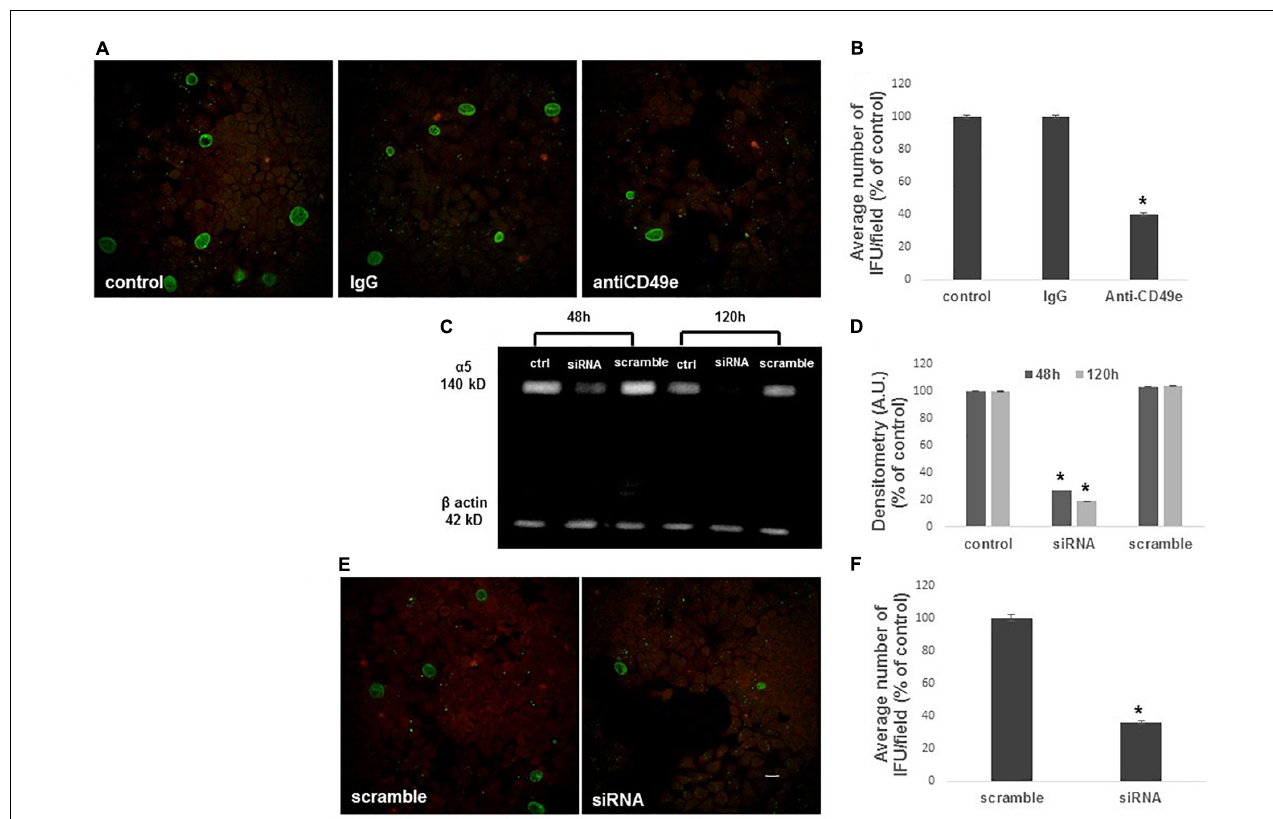
FIGURE 4 | Inhibition of C. trachomatis infection by α 5 integrin subunit blocking or ITGA5 gene silencing. HeLa cells were treated or not with an anti-CD49e antibody or control IgG for 1 h, then infected with CT EBs for 48 h. (A,B) Specimens were stained for chlamydial membrane lipopolysaccharide antigen. Representative micrographs are shown. C. trachomatis infectivity was evaluated as number of IFUs/microscopic field. Results were expressed in percentage compared with control, taken as 100%. Bars represent median values, error bars represent median absolute deviations. Statistical significance was calculated vs. control. ∗ P ≤ 0.01. (C,D) Western blotting of α 5 integrin subunit expression in control, ITGA 5 siRNA and scramble Hela cells, evaluated at 48 and 120 h post-siRNA. Quantification of α 5 integrin subunit was normalized on β -actin. Bars represent mean values based on three independent experiments, error bars represent standard deviations. (E,F) HeLa cells treated with siRNA or scramble were infected with CT EBs for 48 h, and then stained for chlamydial membrane lipopolysaccharide antigen. Bar: 20 µ m. Results were expressed in percentage compared with scramble, taken as 100%. Bars represent median values, error bars represent median absolute deviations. Statistical significance was calculated vs. control. ∗ P ≤